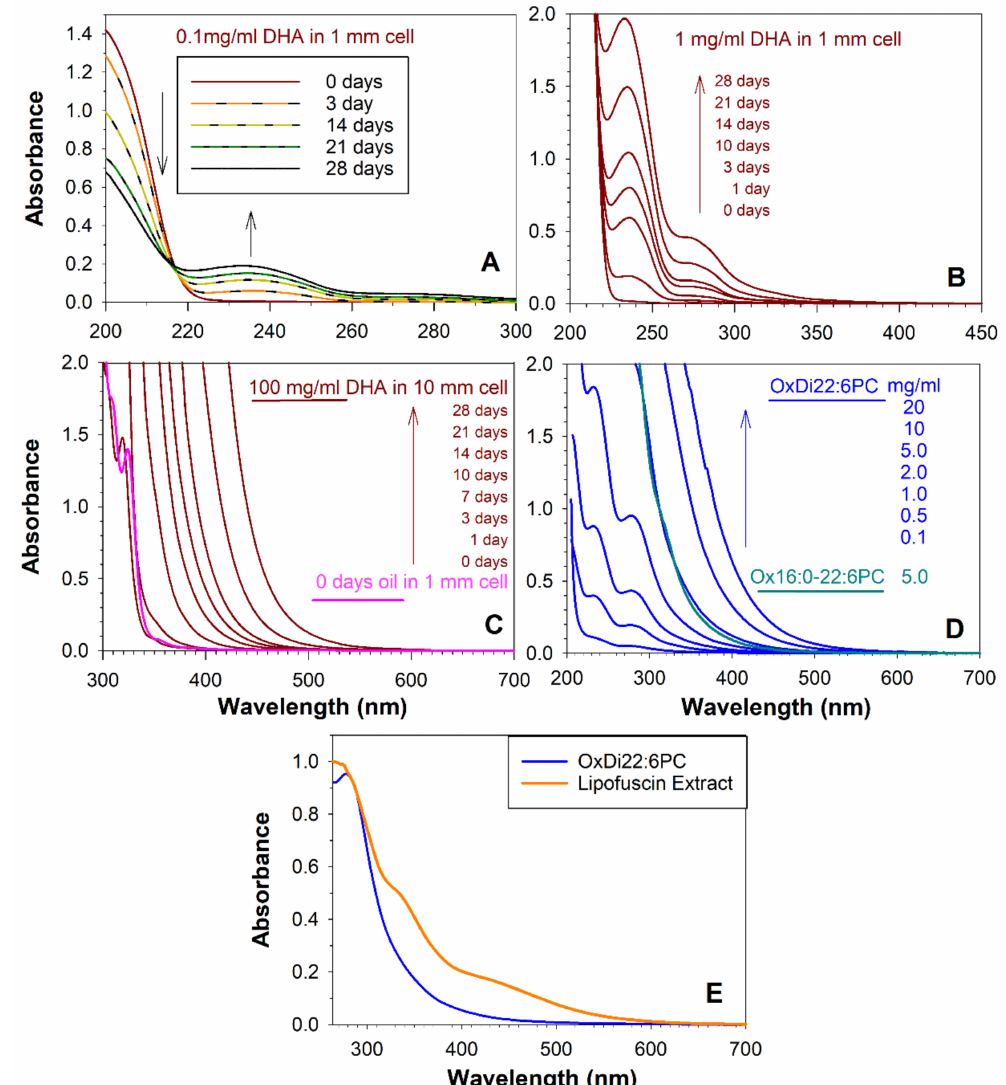
Figure 1. Autooxidation of docosahexaenoic acid (DHA) and docosahexaenoate (DHE) in phospholipids results in the formation of products absorbing ultraviolet and visible light. Absorption spectra of DHA after indicated times of autooxi- dation of DHA as an oil under aerobic conditions at 37 ◦ C, then solubilised in acetonitrile:methanol (1:1), and monitored at a concentration of 0.1 mg/mL DHA in a cell with 1 mm optical pathlength ( A ), 1 mg/mL in a cell with 1 mm optical pathlength ( B ), and 100 mg/mL in a cell with 10 mm optical pathlength ( C ). Graph C also includes the absorption spectrum of pure DHA oil recorded in a cell with 1 mm optical pathlength. ( D ) Absorption spectra of autooxidised for 28 days at 37 ◦ C phosphatidylcholines with one (Ox16:0-22:6PC) or two (OxDi22:6PC) DHE acyl chains at indicated concentrations of the initial phospholipid recorded in a cell with 10 mm optical pathlength. Ox16:0-22:6PC was solubilised in chloroform, while OxDi22:6PC was solubilised in phosphate buffer saline (PBS). ( E ) Comparison of the absorption spectra of OxDi22:6PC with lipophilic extract of lipofuscin solubilised in chloroform normalised to the same value at 284